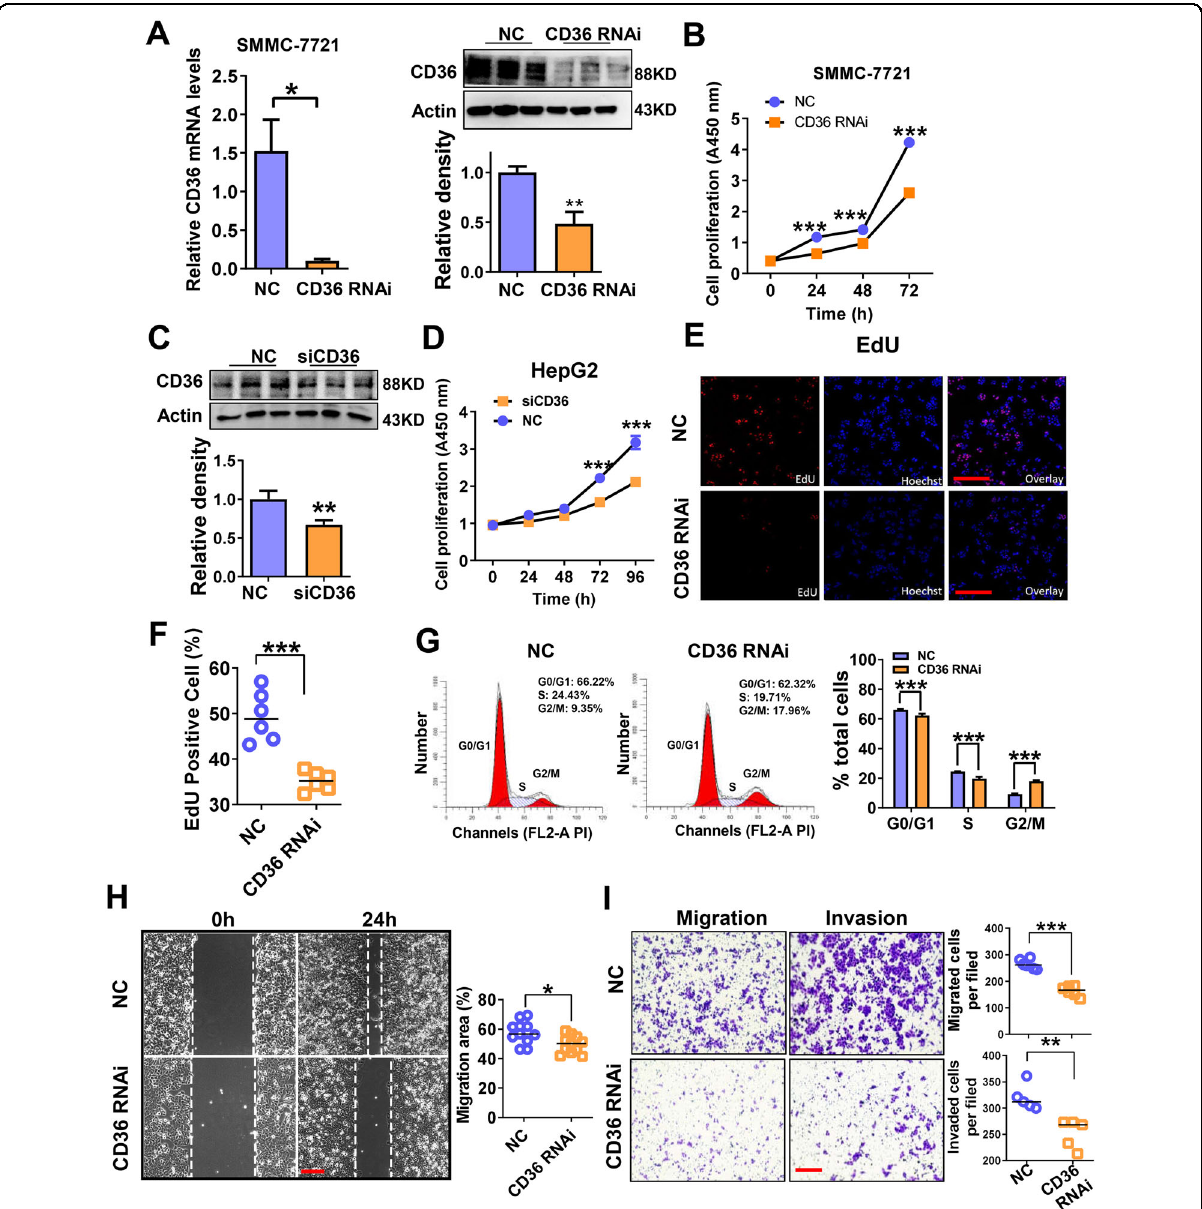
Fig. 2 CD36 knockdown has the negative impact on the proliferation, migration, and invasion of HCC cells. CD36-knockdown (CD36 RNAi) cell line was established by transfecting CD36 shRNA lentiviral construct and targeting sequence 5 ′ -GGCTGTGTTTGGAGGTATT CT-3 ′ or scrambled shRNA lentivirus as control (NC) to SMMC-7721 cells. A The knockdown ef fi ciency of CD36 in SMMC-7721 cells was detected by real-time PCR and western blotting ( n = 3). B The proliferation of the control and CD36 RNAi cells in SMMC-7721 cells was measured by CCK-8 assay ( n ≥ 5). C The knockdown ef fi ciency of CD36 in HepG2 cells was detected by western blotting ( n = 3). D The proliferation of the control and CD36 RNAi cells in HepG2 cells was measured by CCK-8 assay ( n ≥ 5). E The proliferation of the control and CD36 RNAi cells in SMMC-7721 cells was measured by EdU assay, the Edu-positive cells were shown in the following ( F ) ( n ≥ 5). G Cell cycle analysis was performed after culture for 48 h using fl ow cytometer ( n = 3). H Scratch-wound cell migration assay of the control and CD36 RNAi cells ( n = 5). I Cell migration and invasion ability was evaluated by transwell assay ( n = 5). Cell number refers to the average number ± SEM per fi eld counted at ×200 magni fi cation. * P < 0.05, ** p < 0.01, and *** p < 0.001 compared with the NC group. Bar = 100 μ m ( C , E , F ). P -value was calculated using Student ’ s t